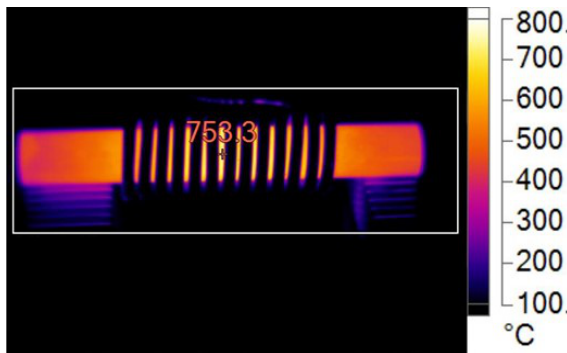
Figure 23. Actual photo of the induction heating system heating the workpiece to 753.3 degrees Celsius, measured by the infrared thermal imager.